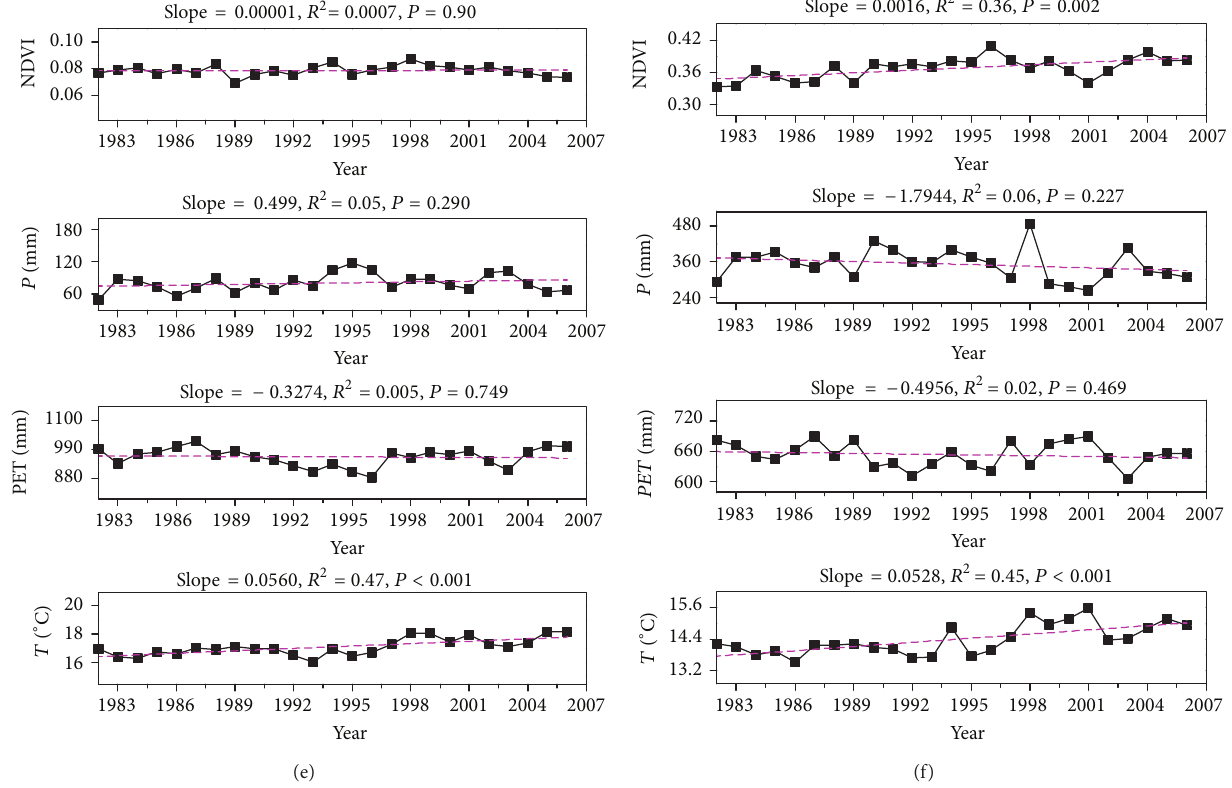
Figure 2: Interannual variations of growing season mean NDVI, growing season 𝑃 , growing season PET, and growing season 𝑇 forest, (b) meadow steppe, (c) typical steppe, (d) desert steppe, (e) desert, and (f) cropland during the period 1982–2006.